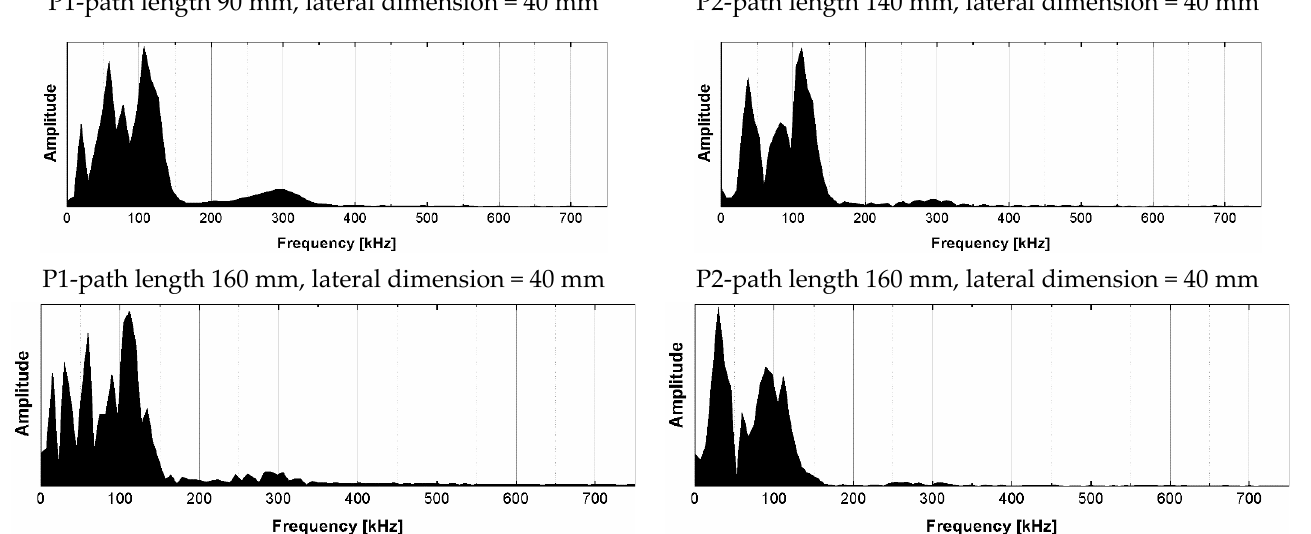
Figure 9. Frequency spectra obtained by fast Fourier transform of signals registered after transmission through epoxy concrete samples with different shape and dimensions.